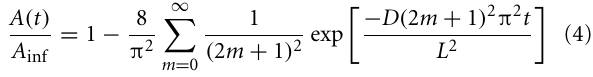
Figure 12 | Comparison between sorption and desorption kinetics as represented in Fick’s diagrams. Measurement performed at p / p 0 = 0 . 3, via time-resolved FTIR spectroscopy. Analytical band: ν (CO) at 1023cm − 1 .